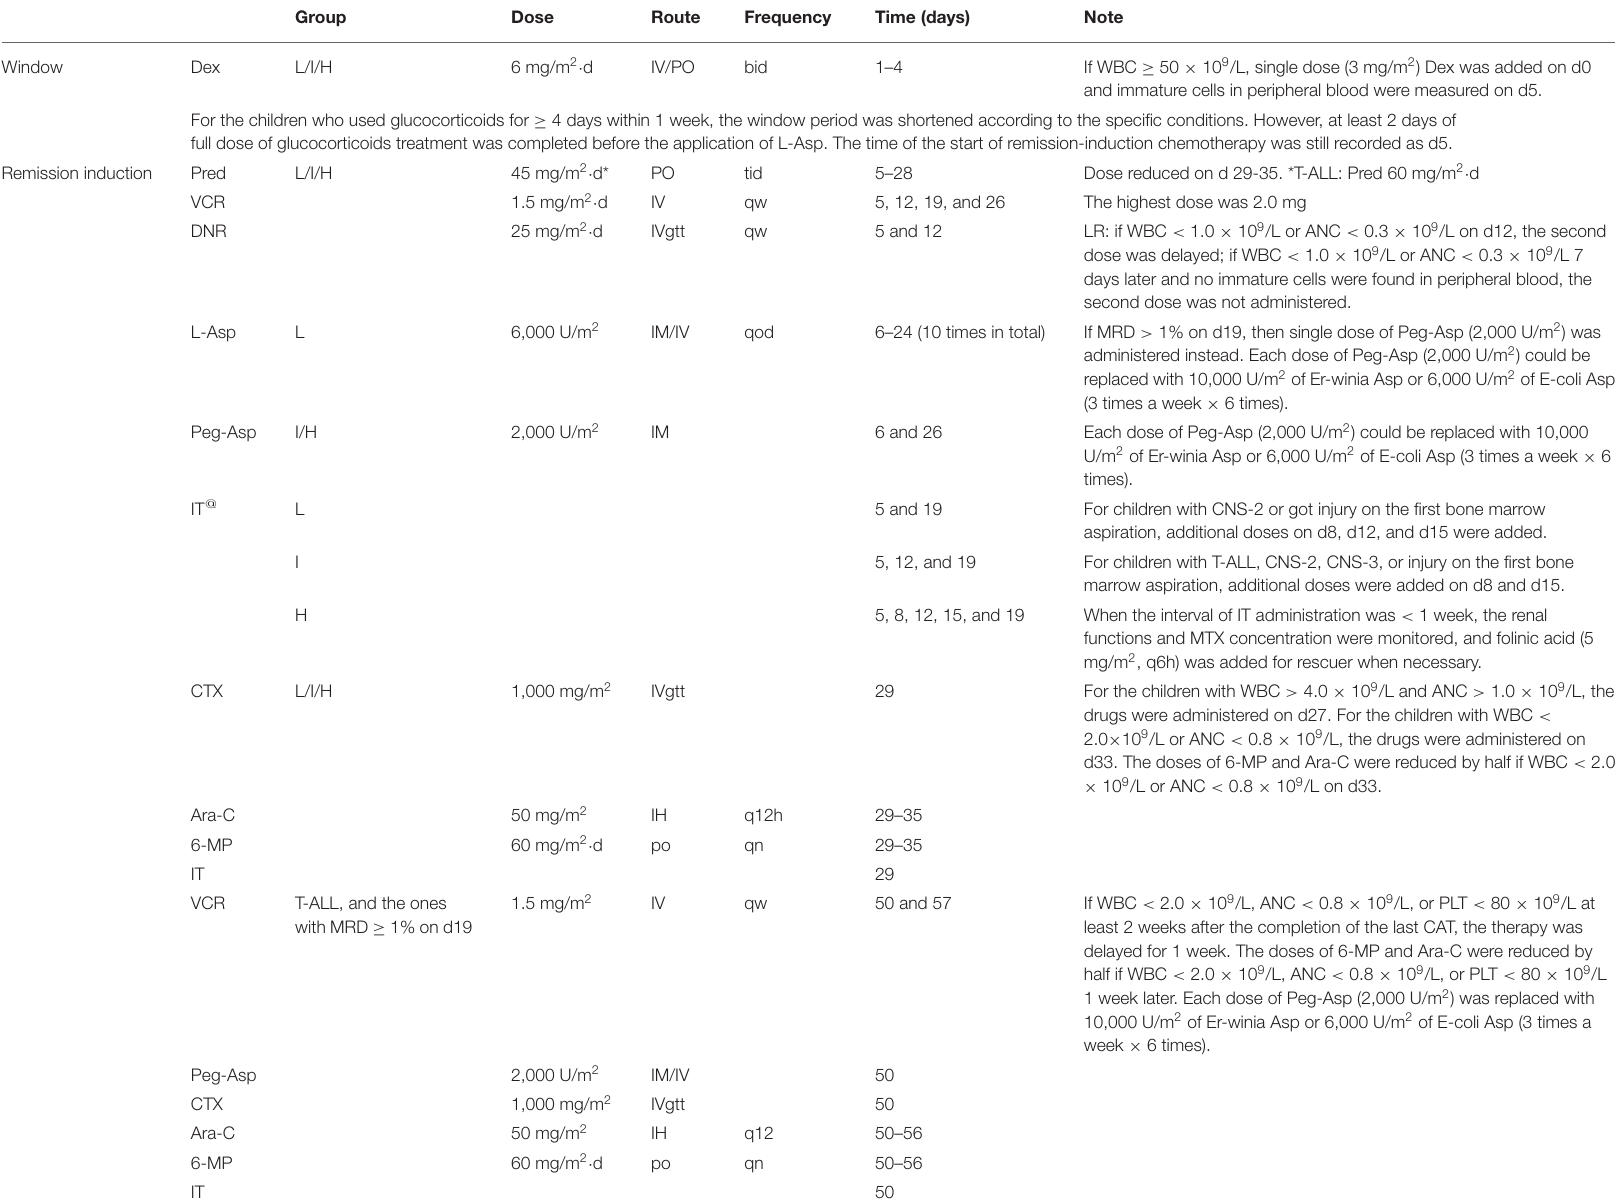
TABLE 1 | Remission-induction chemotherapy. Group Dose